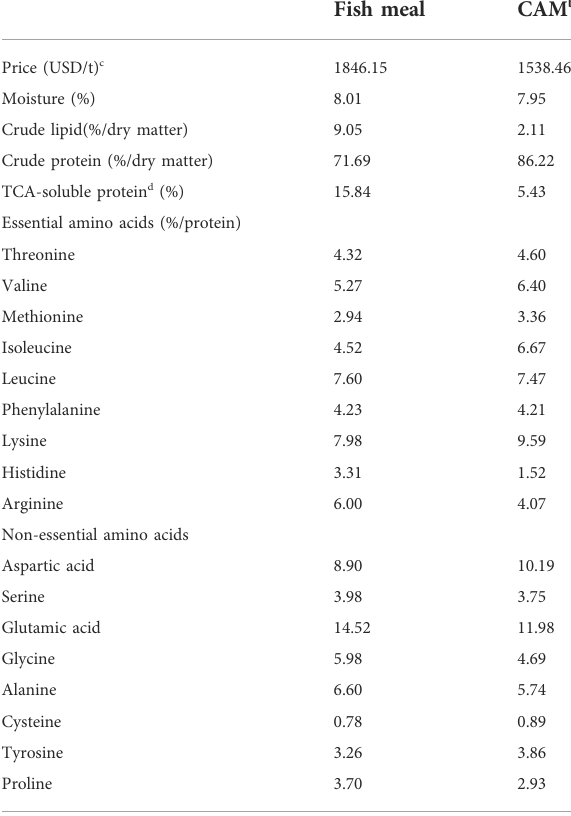
TABLE 4 The nutritional composition and price of fi sh meal and TABLE 5 Fatty acids pro fi le of fi sh meal and Clostridium Clostridium autoethanogenum meal (CAM) a . autoethanogenum meal (CAM) a Fish meal